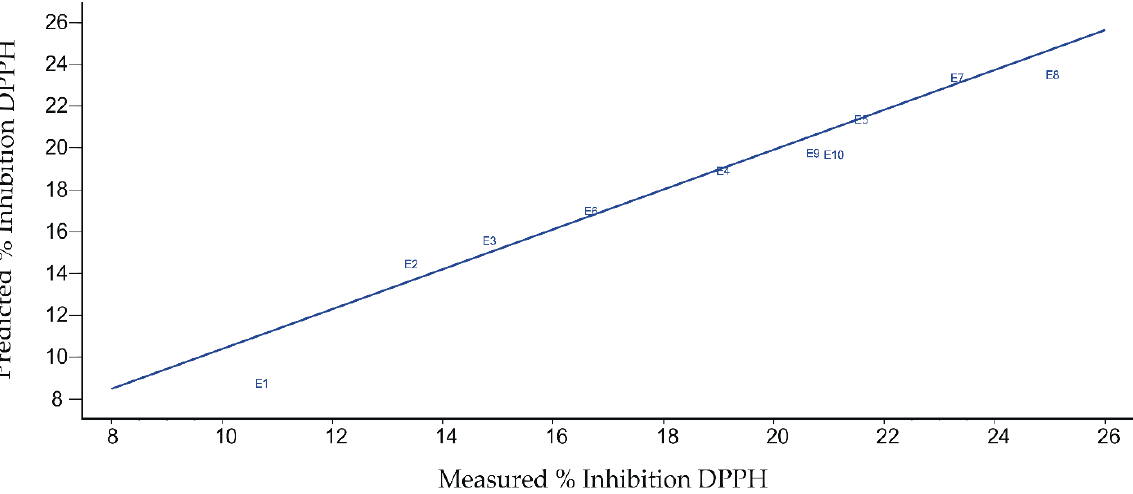
Figure 13. Plot of predicted inhibition from the voltammetric data vs. measured inhibition obtained from DPPH spectrophotometric method.